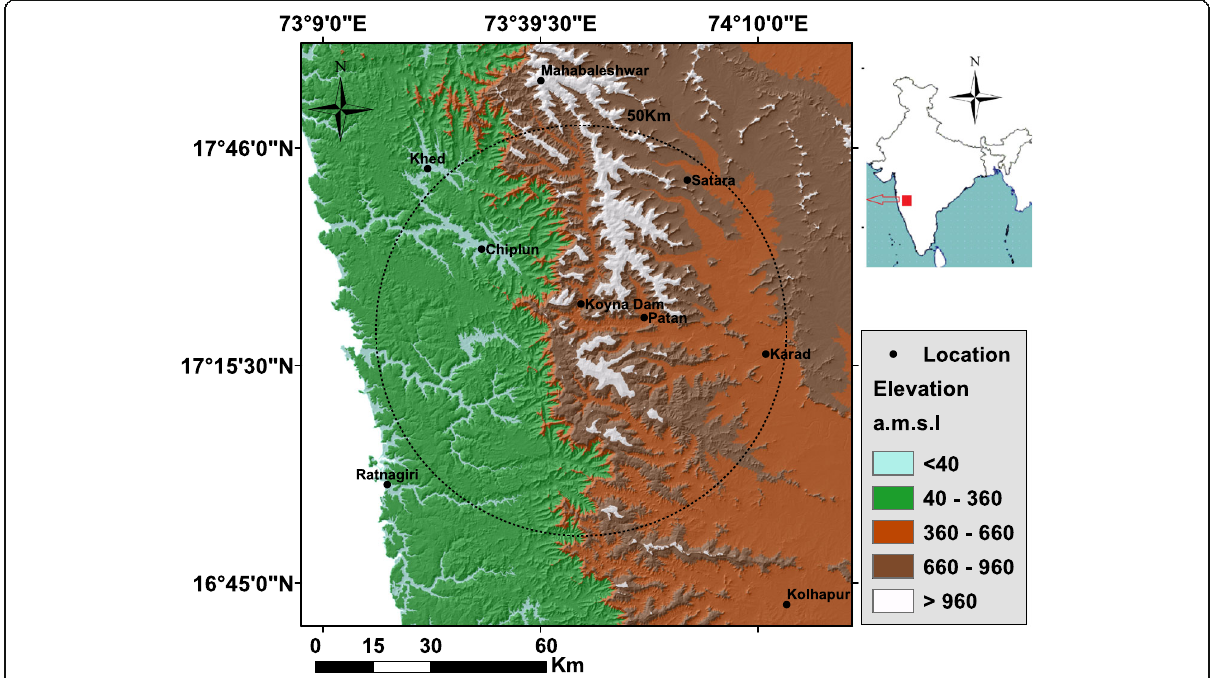
Fig. 3 Spatial distribution of elevation in and around Koyna region (100 Km